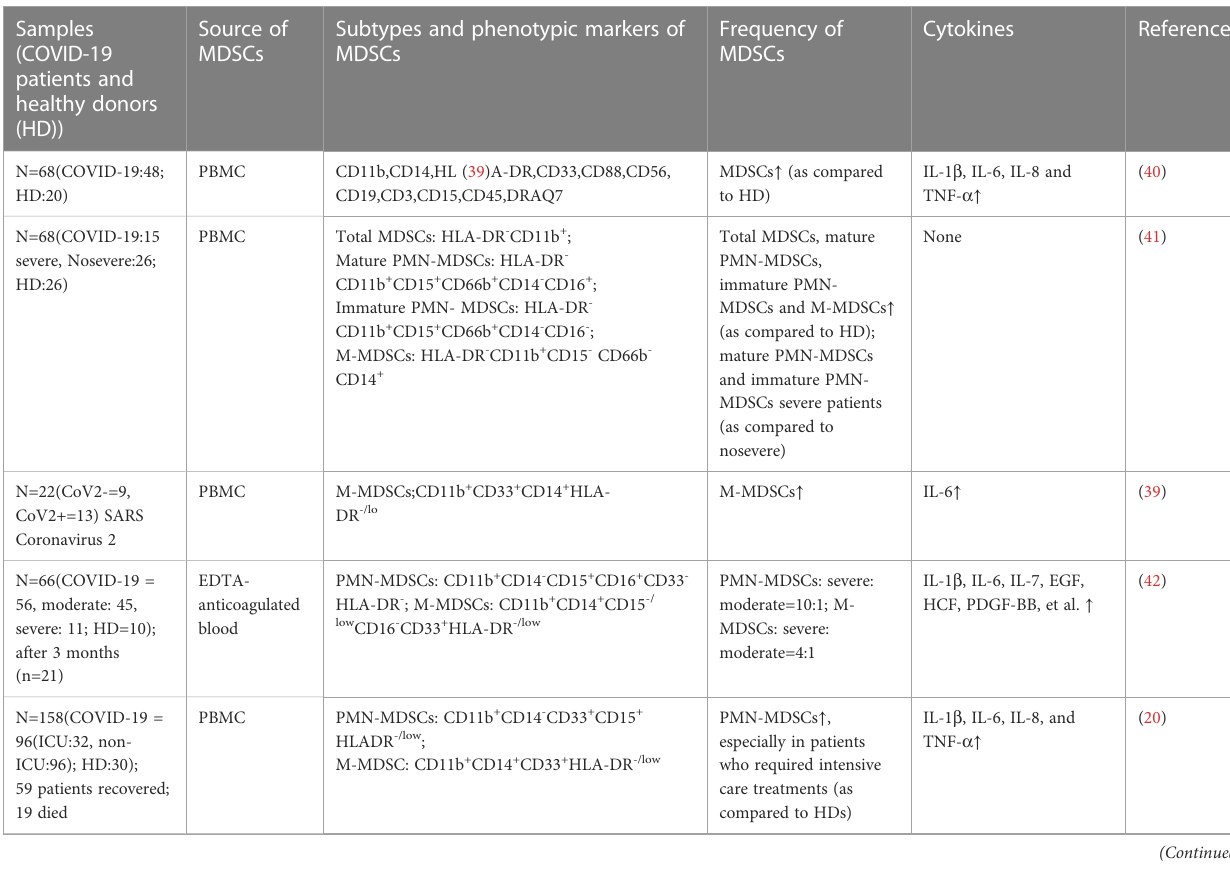
TABLE 1 Summary current studies on MDSCs in COVID-19 patients.